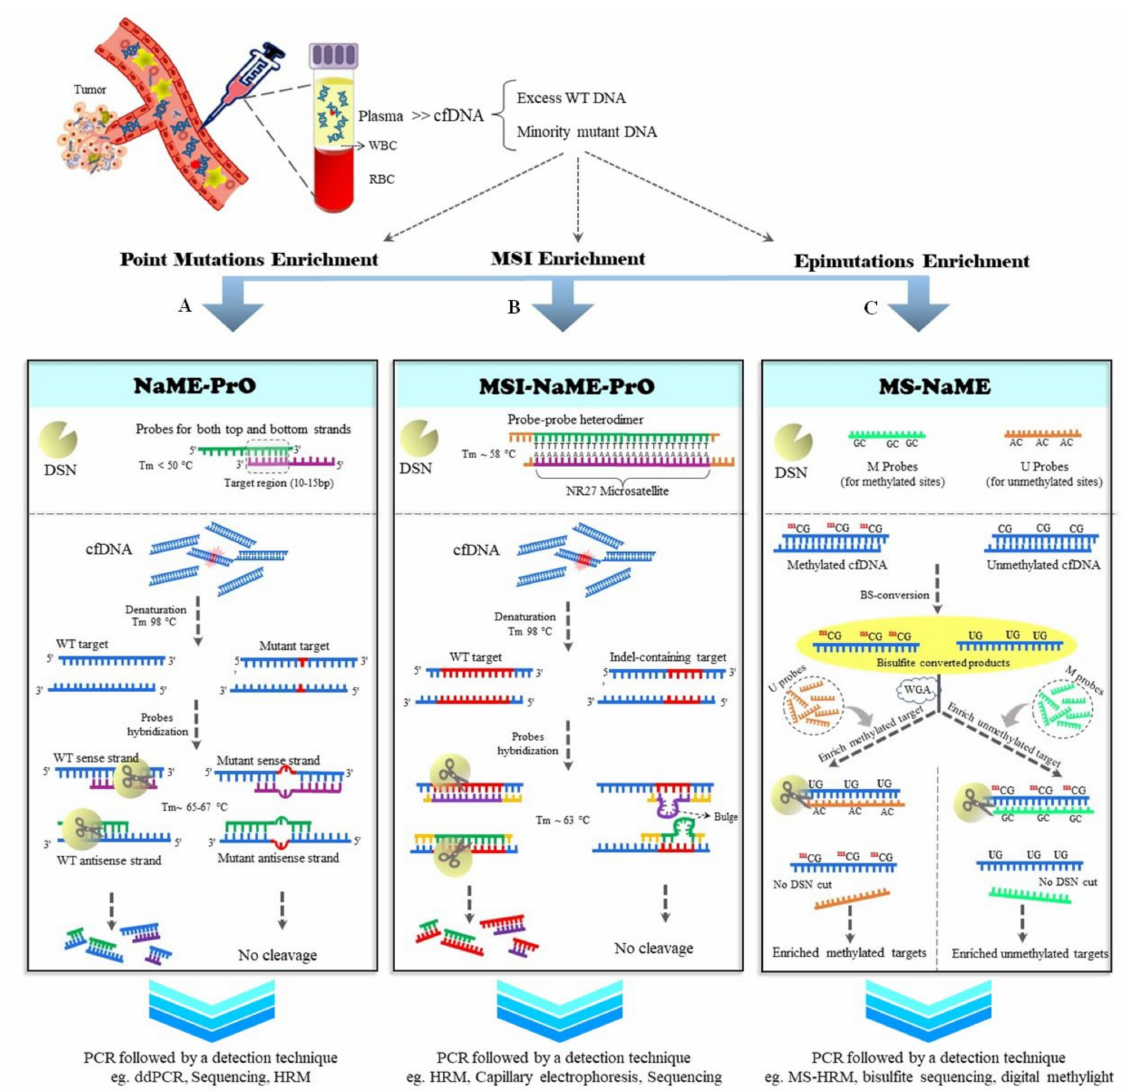
Figure 1. Applications of nuclease-assisted minor-allele enrichment (NaME) method in cell-free